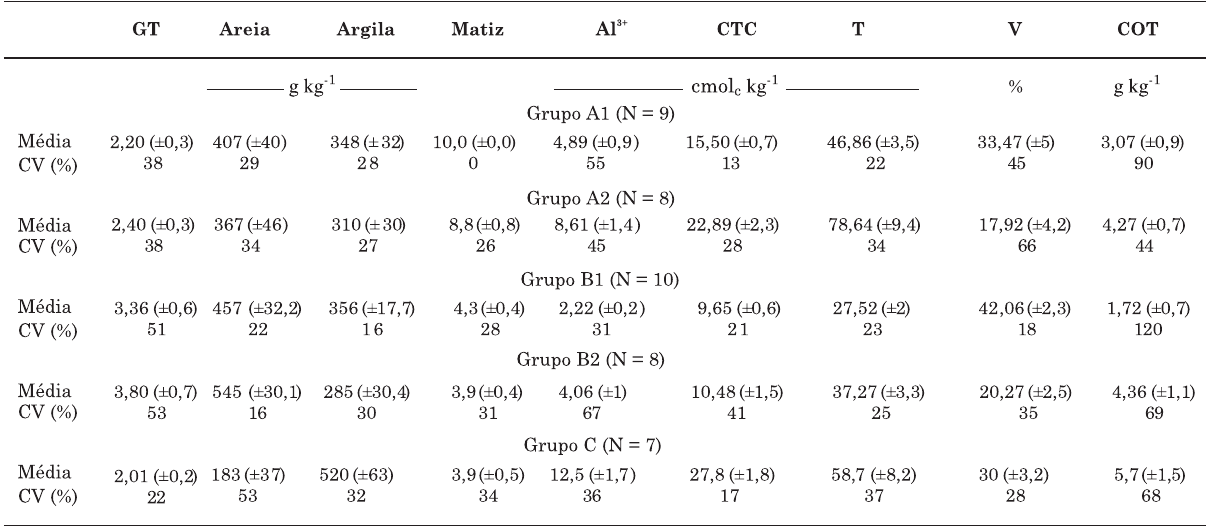
Quadro 4. atributos do horizonte B dos perfis de argissolos em cada grupo gerado pela análise de agru-